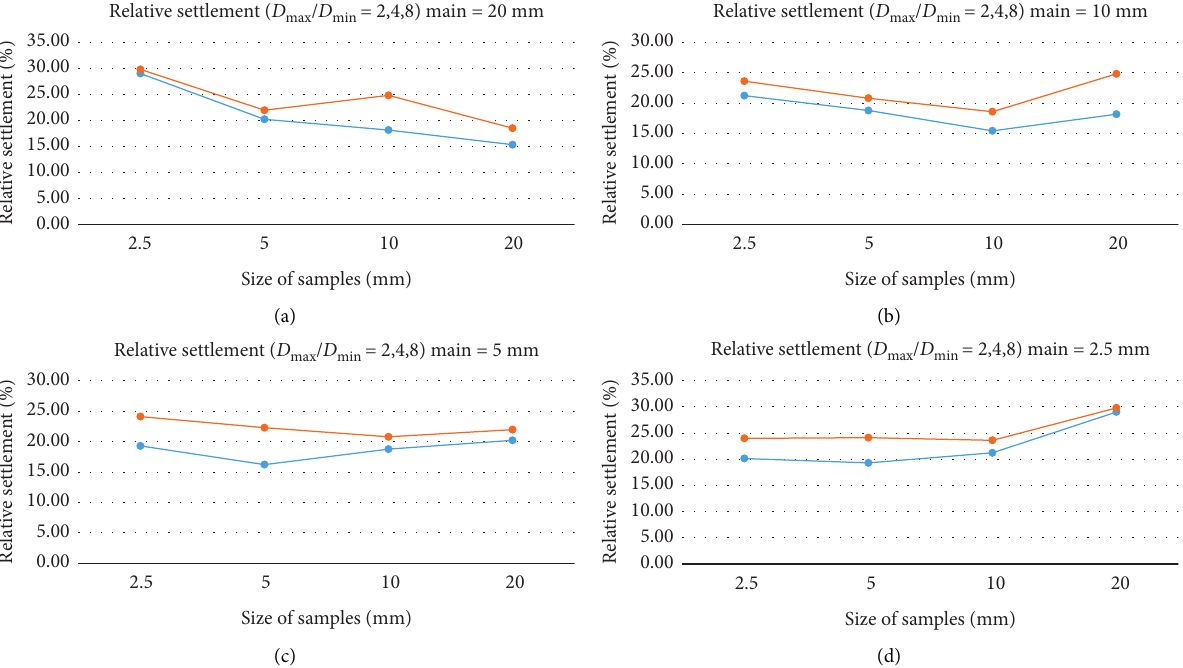
Figure 11: Relative settlement of aggregates for different granulations by funnel and spoon precipitation method (half weight of materials, aggregates with sizes of 2.5, 5, 10, and